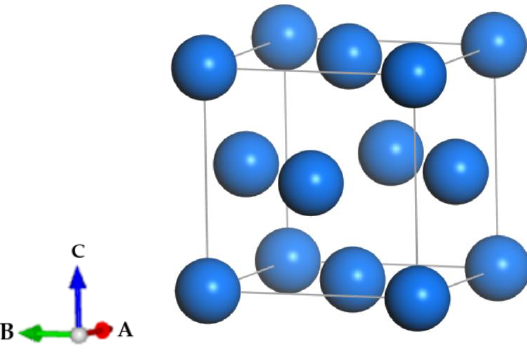
Figure 1. A single cell structure of δ - Pu.